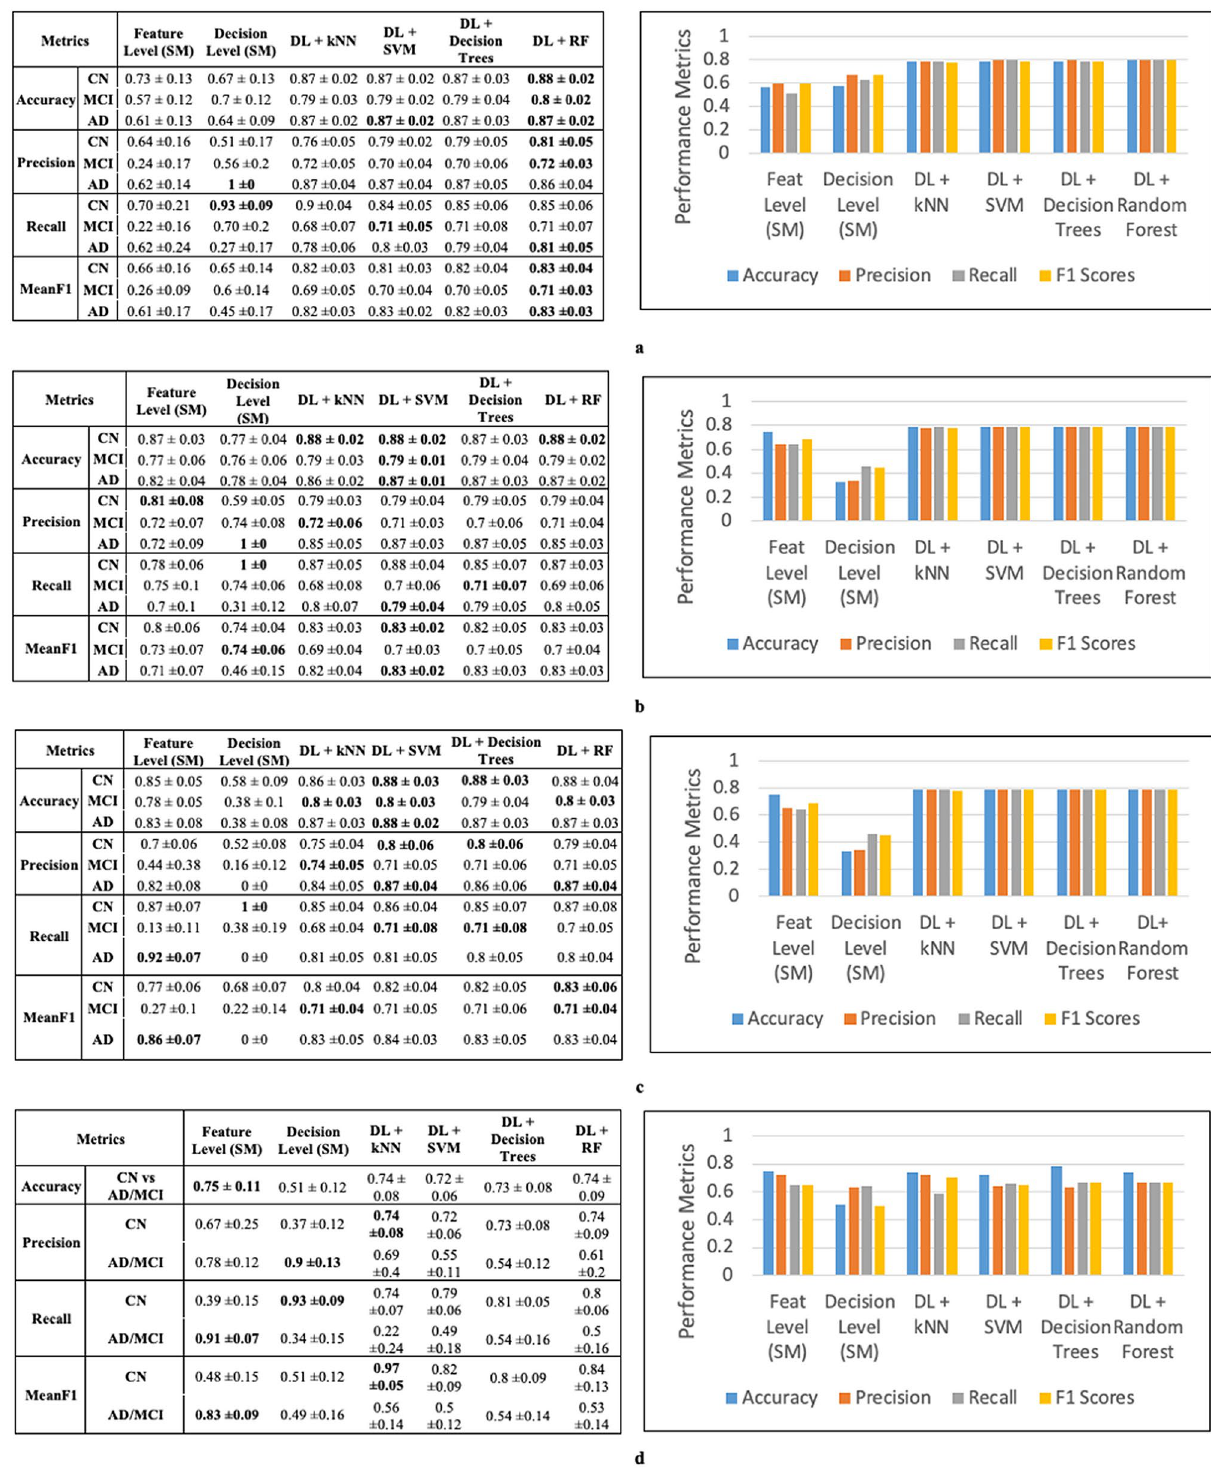
Figure 5. Internal cross validation results for integration of data modalities to predict Alzheimer’s stage ( a ) Imaging + EHR + SNP. Deep learning prediction performs better than shallow learning predictions ( b ) EHR + SNP Deep learning prediction performs better than shallow learning predictions ( c ) Imaging + EHR deep learning prediction performs better than shallow learning predictions ( d ) Imaging + SNP results. Shallow learning gave a better prediction than deep learning due to small sample sizes. ( kNN k-Nearest Neighbors, SVM support vector machines, RF random forests, SM shallow models, and DL deep